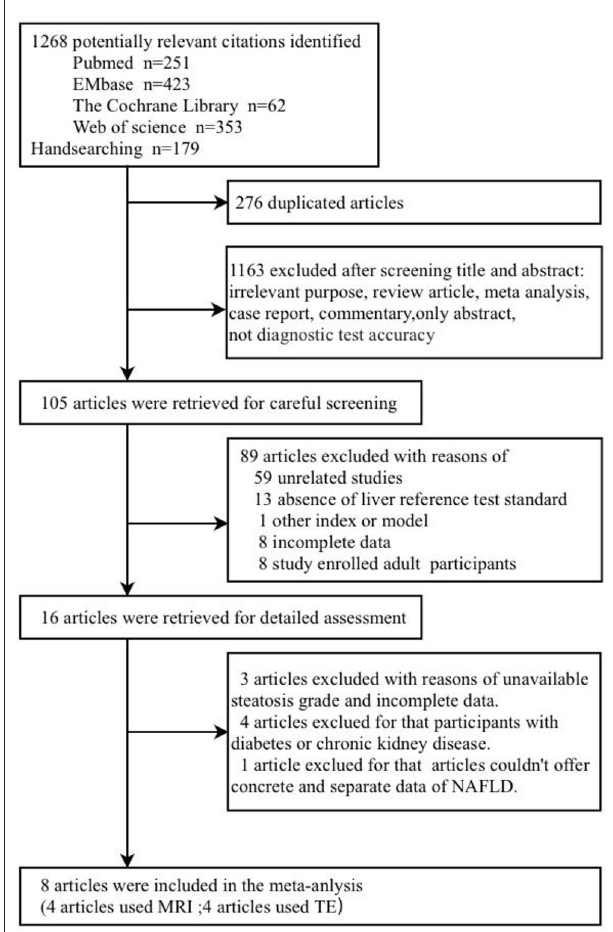
FIGURE 1 | The articles included in the